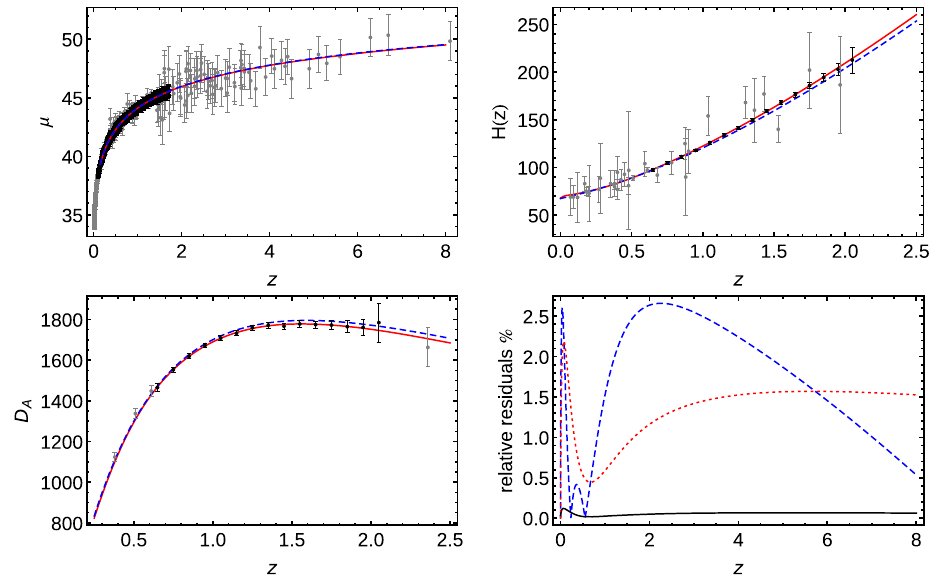
Fig. 1 Top left panel: Comparison between the selected phenomeno- logical function F fit ( z ; b , c , d , e ) given in Eq. (12) (solid red) with the Planck Λ CDM (dashed blue) described in the text. Gray dots and bars are distance modulus values and related errors for SNe Union and Mayflower GRBs samples and black ones are for our generated SNe mock data. Top right panel: comparison between the H ( z ) function derived from Eq. (12) (solid red) with that corresponding to the Planck Λ CDM (dashed blue) described in the text. Gray dots and bars are expansion rate values and related errors from cosmic chronometers and